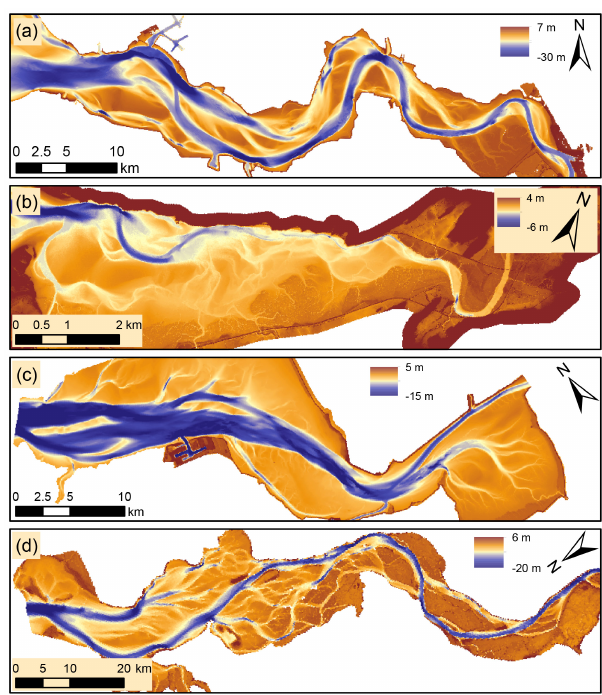
Figure 1. Bathymetry from (a) the Western Scheldt (NL), (b) the Dovey (Wales), (c) the Eems–Dollard (NL) and (d) the Columbia River Estuary (USA). Source: (a, c) Rijkswaterstaat (NL), (b) Natural Resources Wales, (d) Lower Columbia Estuary